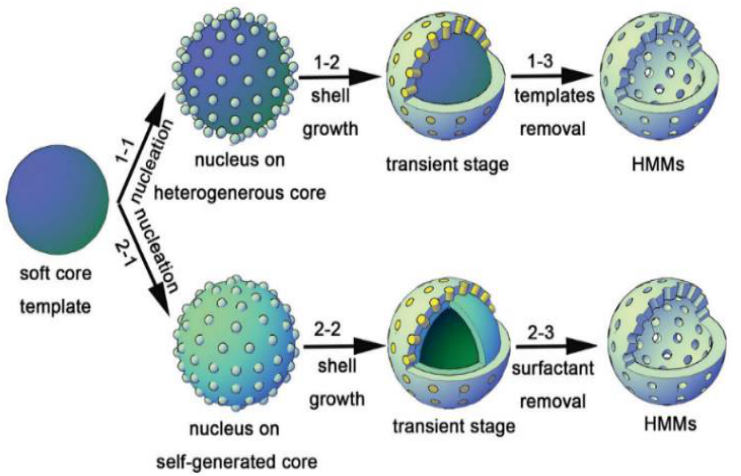
Figure 2. Illustration of the soft template route via (1-1) heterogenous soft-templating route and (2-2) self-generated soft-templating route to produce hollow-structured mesoporous materials (HMMs) [24].